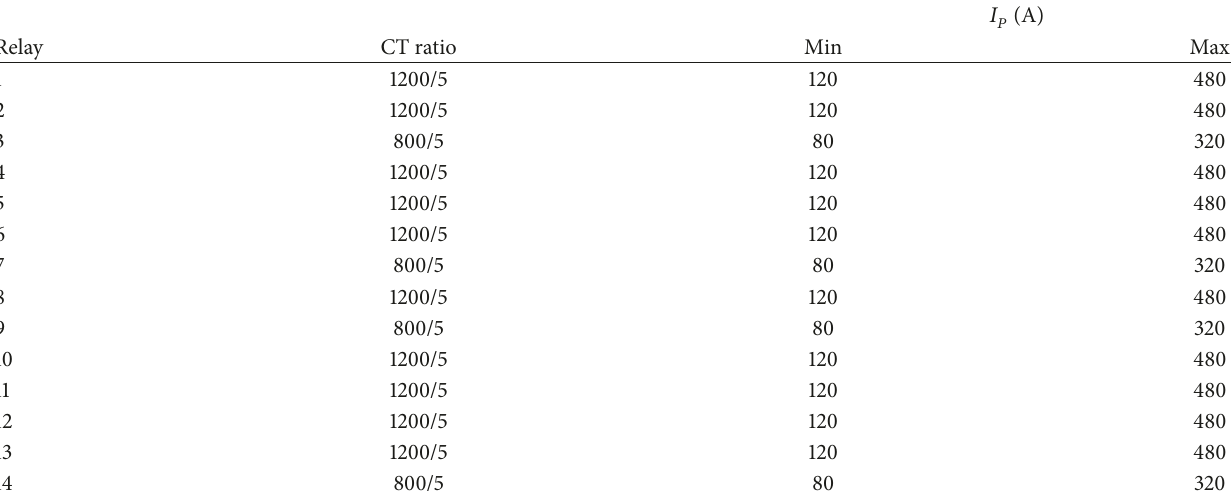
Table 14: The main characteristics of the 8-bus test